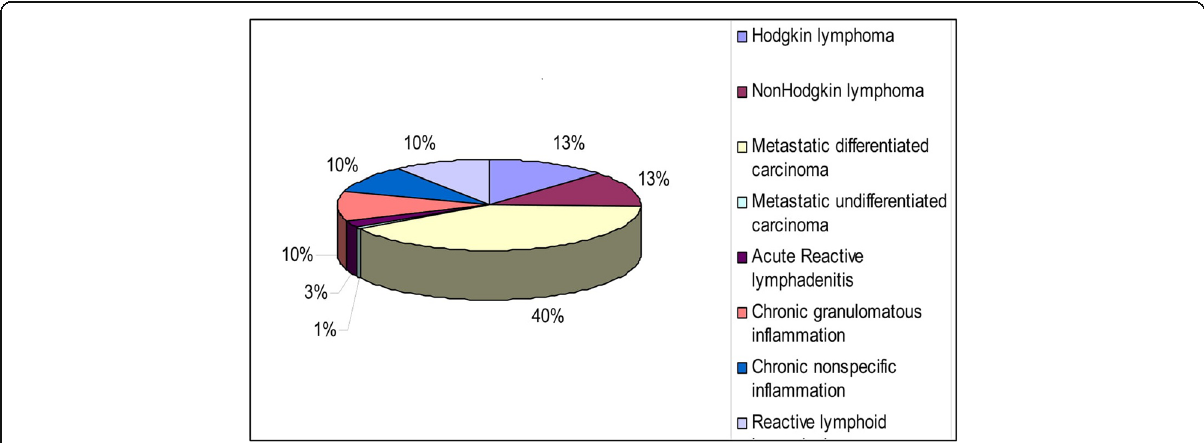
Fig. 1 Pie chart showing the subgroups of lymph nodes according to the histopathology